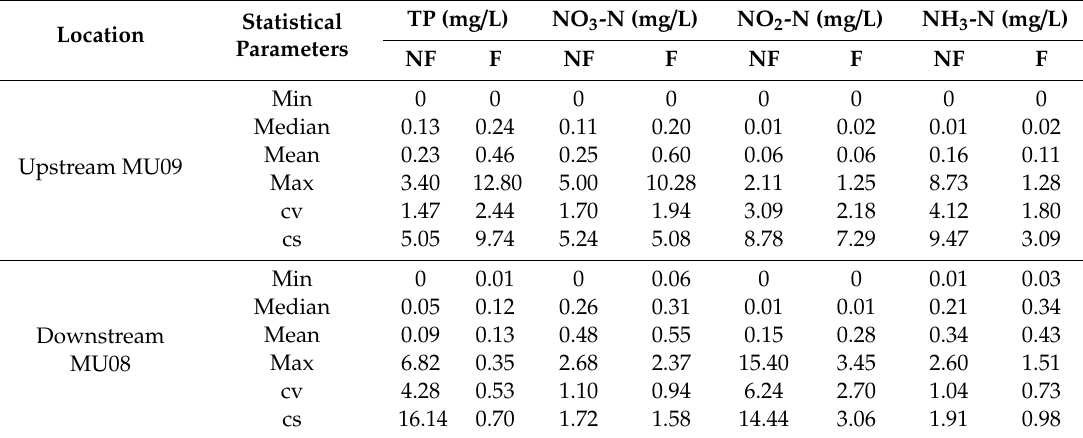
Table 2. Comparison of nutrient contents in the non-flood (NF) and flood (F) seasons in the upper (Upstream MU09) and lower (Downstream MU08) reaches over the last two decades